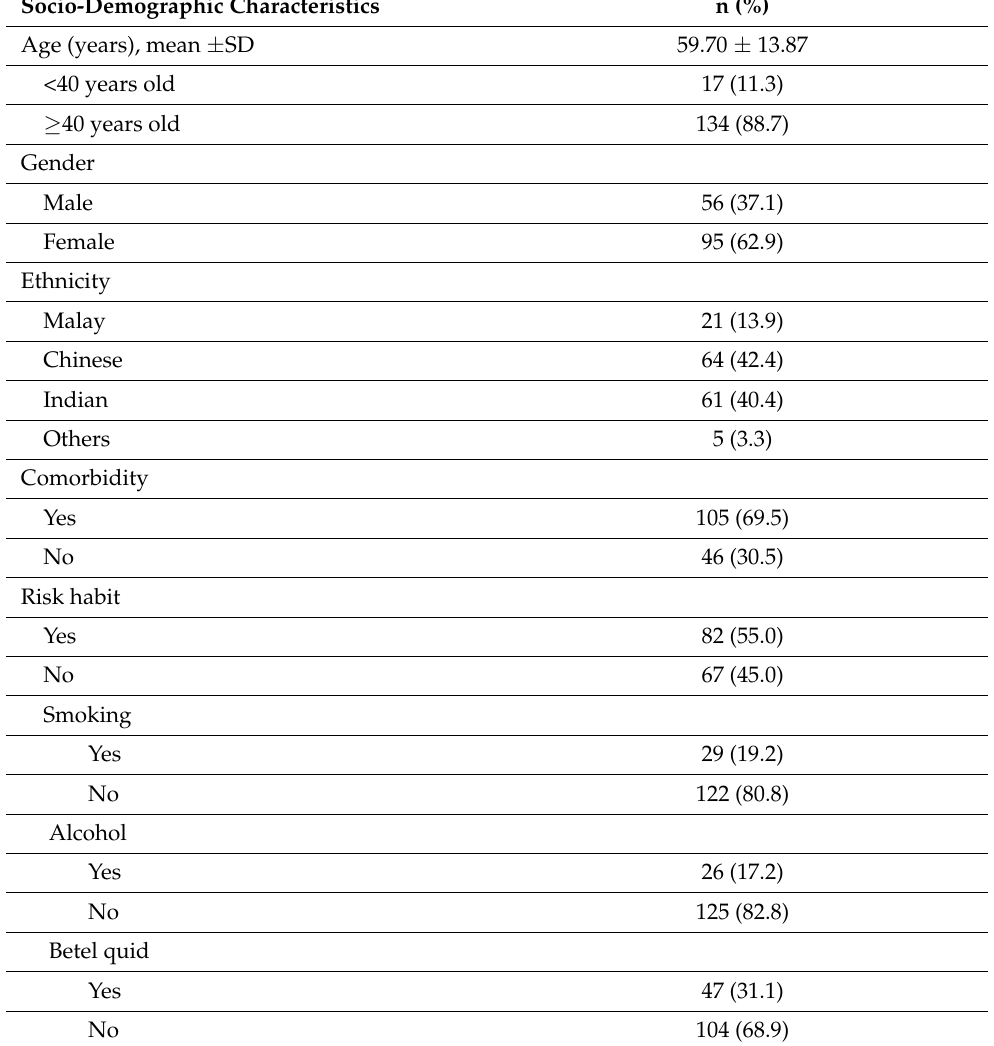
Table 2. Socio-demographic characteristics of study population ( n =